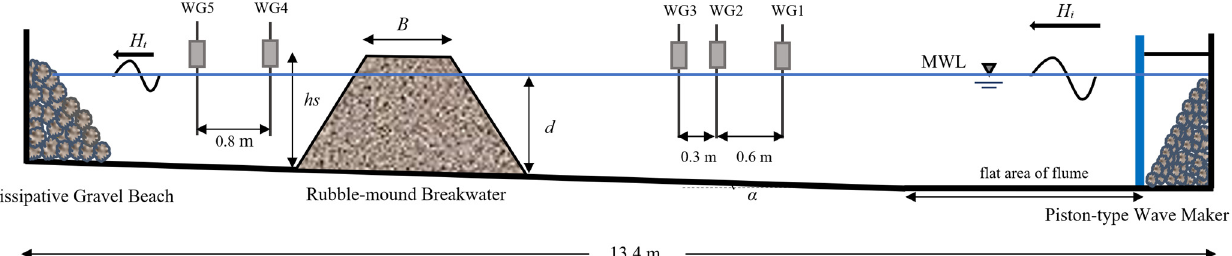
Figure 2. Schematic view of the wave flume and experimental arrangement for measuring incident, transmitted, and reflected wave fields in the wave flume.